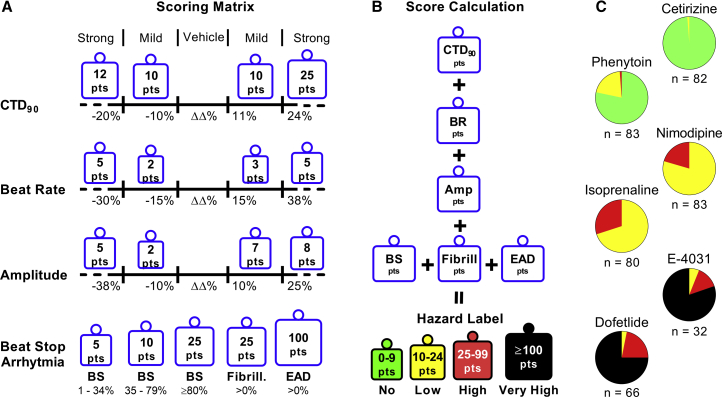
Development of the Scoring Matrix and Calculation Algorithm for Hazard Identification(A) The scoring matrix represents a points card where for each parameter a weighted score is given dependent on the size and direction of the ΔΔ% effect.(B) Calculation of hazard level is done through a sum of points across all parameters.(C) Scoring of controls over multiple studies: cetirizine (1 μM), phenytoin (5 μM), isoprenaline (0.1 μM), nimodipine (0.1 μM), E-4031 (30 nM), dofetilide (3 nM). n indicates the number of studies, each study contained 4–8 independent experiments.